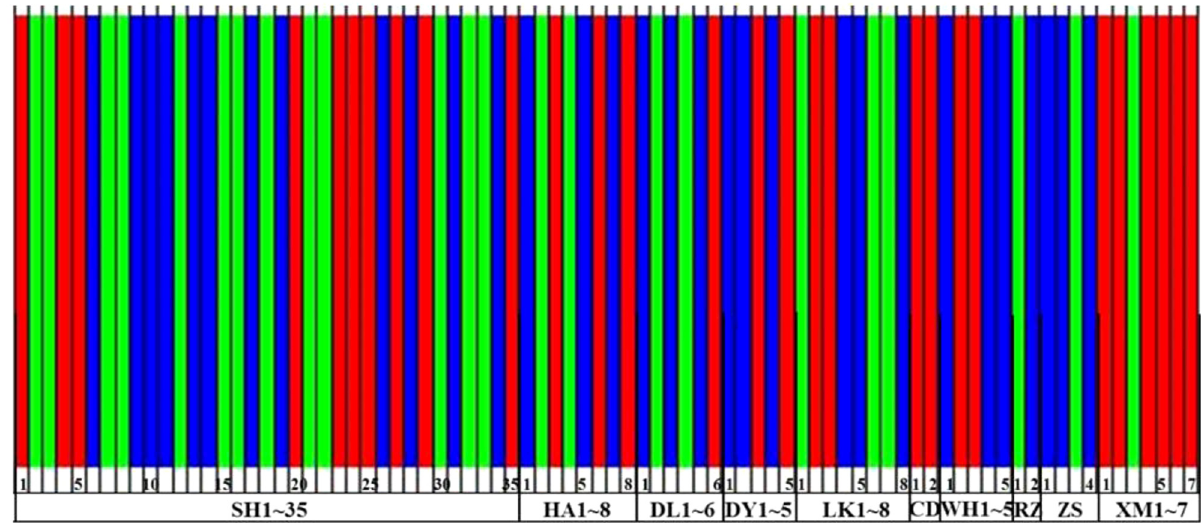
Fig. 2. Bayesian clustering analysis of T. modestus haplotypes.